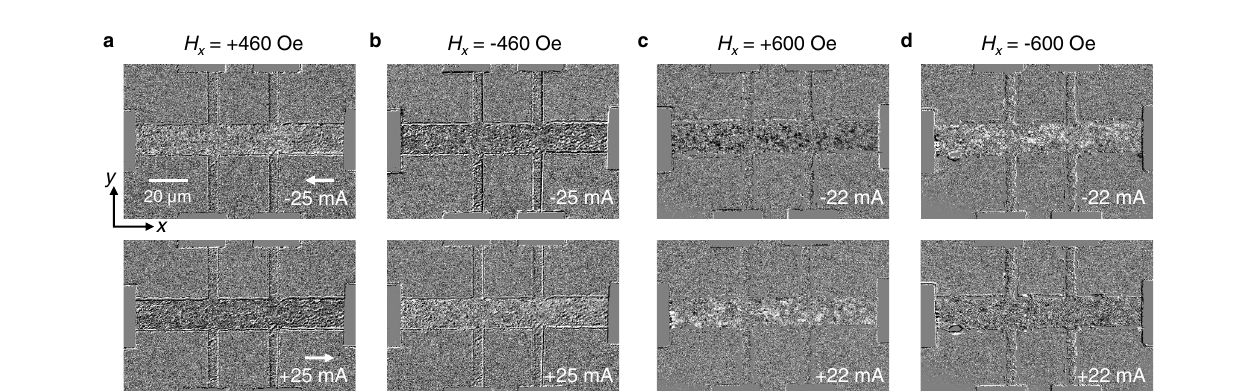
Fig.3|AHEandcurrent-inducedswitchinginMn 3 SnwithMgO,Tiseedlayeror directly grown on substrate. a , d , g Field dependence of Hall resistance of MgO(3)/Mn 3 Sn(12), Ti(2)/Mn 3 Sn(12), and Substrate/Mn 3 Sn(12), respectively. b , e , h Current dependence of Hall resistance of MgO(3)/Mn 3 Sn(12), Ti(2)/